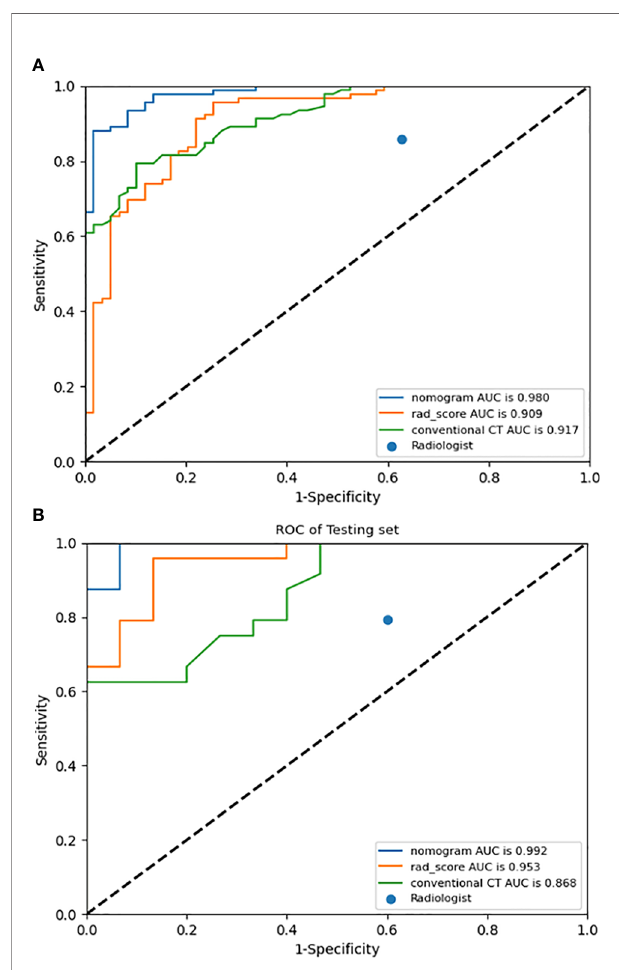
FIGURE 4 | ROC curves of radiomics nomogram, Rad-score, conventional CT model, and judgment by radiologists in the training (A) and validation (B) cohorts.